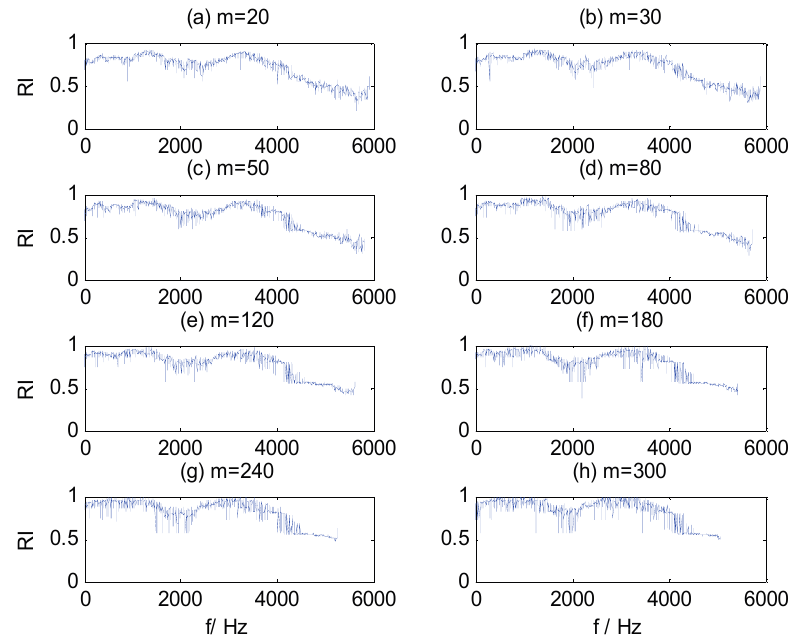
Figure 7. RI value sequences in different window size m. ( a ) m = 20; ( b ) m = 30; ( c ) m = 50; ( d ) m = 80; ( e ) m = 120; ( f ) m = 180; ( g ) m = 240; ( h ) m = 300.